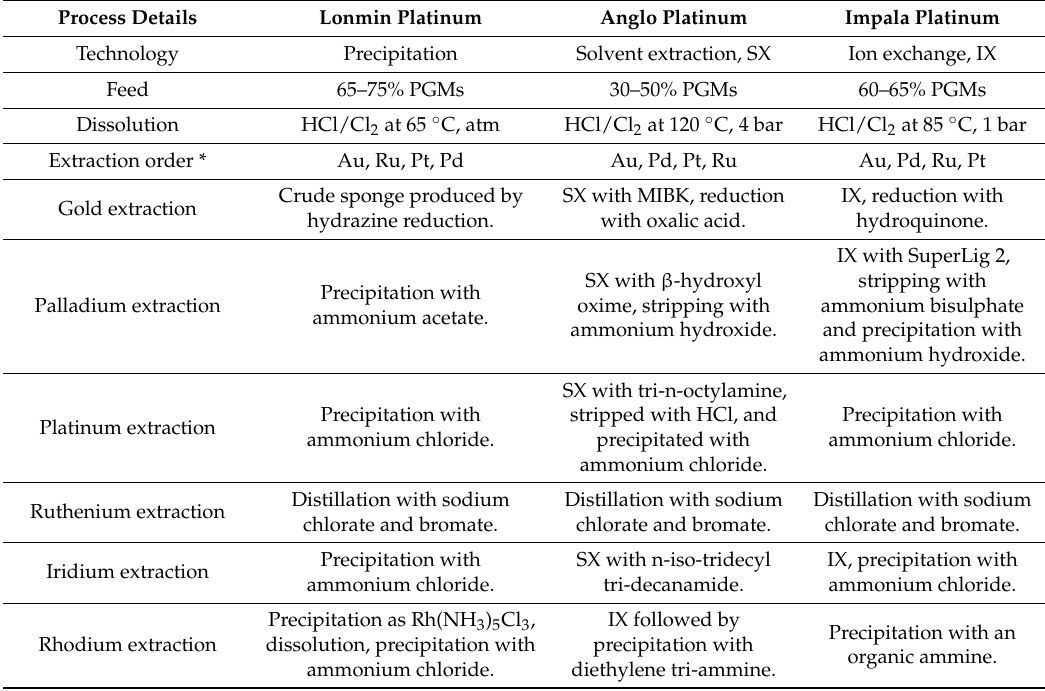
Table 2. Extraction methods in a few PGM refineries (adapted from Crundwell et al.